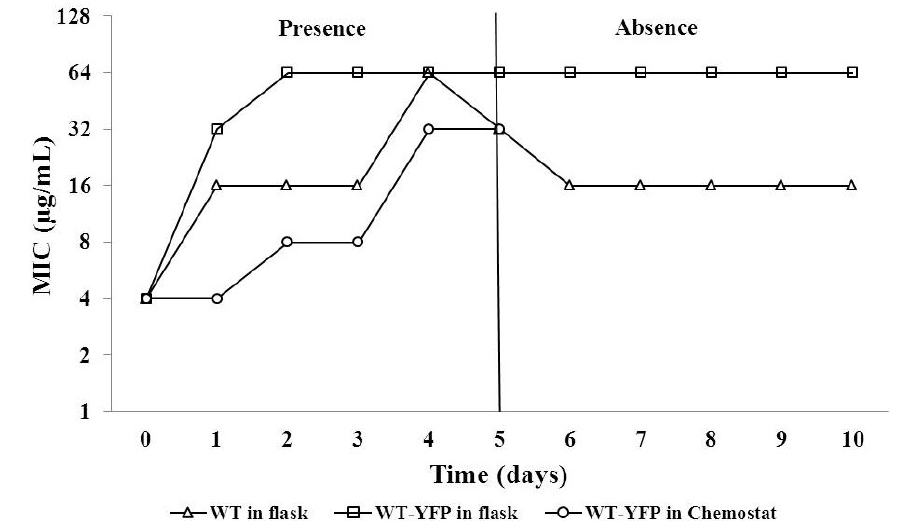
Figure 2. The increase of the MIC during growth of E. coli in the presence of 2 µg/mL amoxicillin for five days and subsequently in absence for another five days. WT, E. coli MG 1655. WT-YFP, WT with genes coding for chloramphenicol resistance and a yellow fluorescent protein. In the chemostat (D = 0.3 h −1 ), a pulse of amoxicillin reaching maximally 2 µg/mL in the culture vessel was given every 8